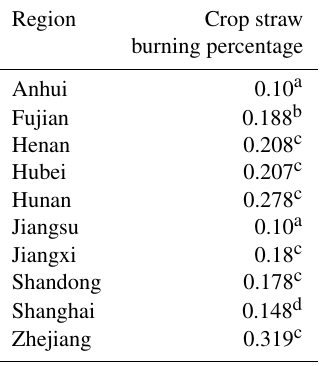
Table 4. Detailed crop straw burned ratio data for each province.